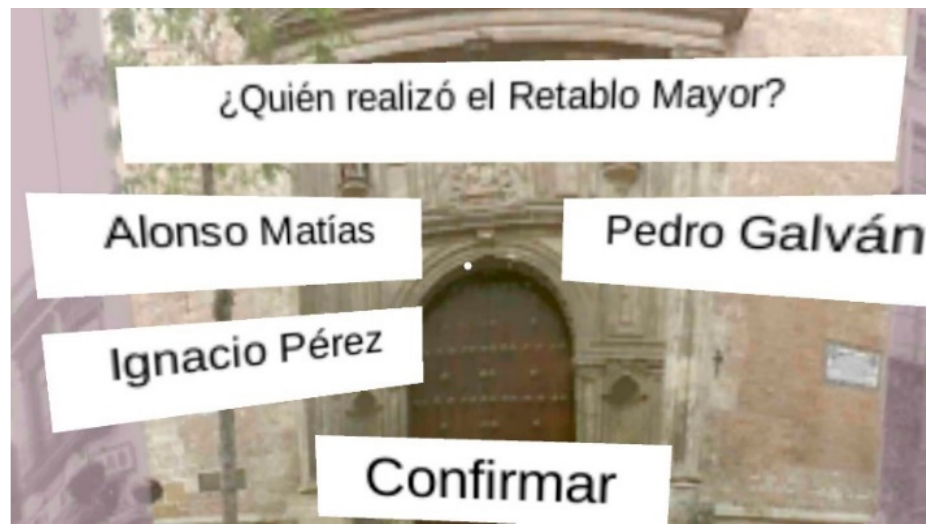
Figure 2. An example of the questions appearing in the produced software. Source: developed by the authors.